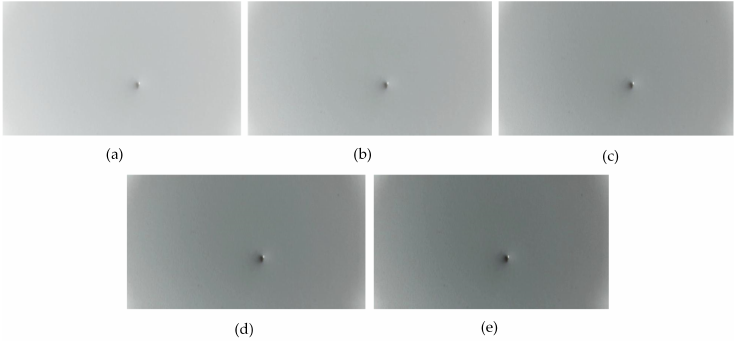
Figure 11. Defect samples with different contrasts. ( a ) Contrast parameter = 0.5, ( b ) contrast parameter = 0.75, ( c ) contrast parameter = 1.0, ( d ) contrast parameter = 1.25, ( e ) contrast parameter = 1.5.